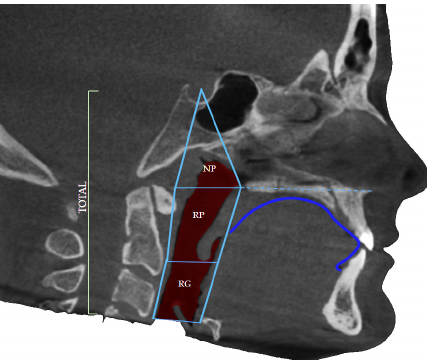
Figure 2. Defined borders of the airway volume consist of the nasopharyngeal (NP) portion as well as oropharyngeal regions: retropalatal (RP) and retroglossal (RG) and dorsum linguae identification.